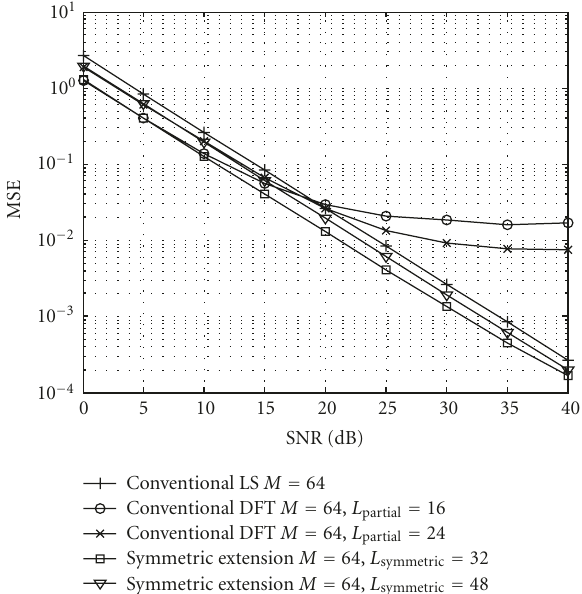
Figure 9: Comparing MSE performance with proposed estimator, conventional DFT estimator, and LS estimator, when M = 64, L partial = 16 . 24, and L symmetric = 32 . 48.